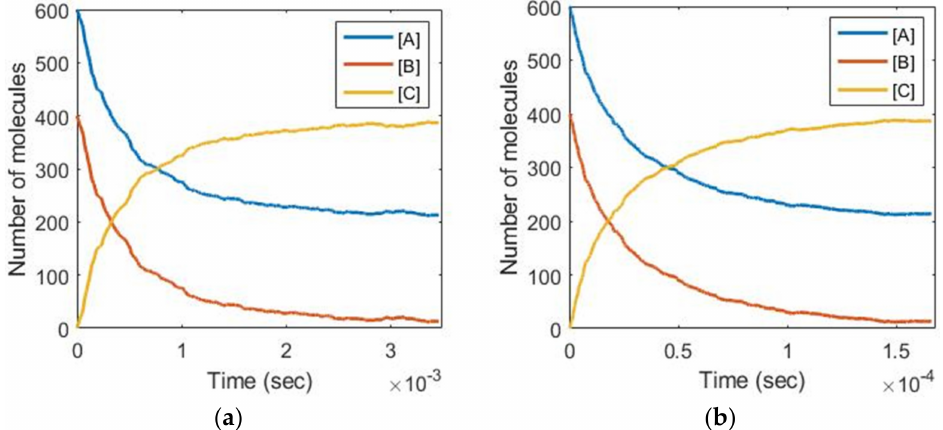
Figure 6. Simulation results of ( a ) Gillespie stochastic algorithm and ( b ) the proposed architecture of Figure 5 for the reactions: A + B ↔ C. Note that the simulated reaction rates of ( b ) are scaled up by 21 than the actual biochemical reaction